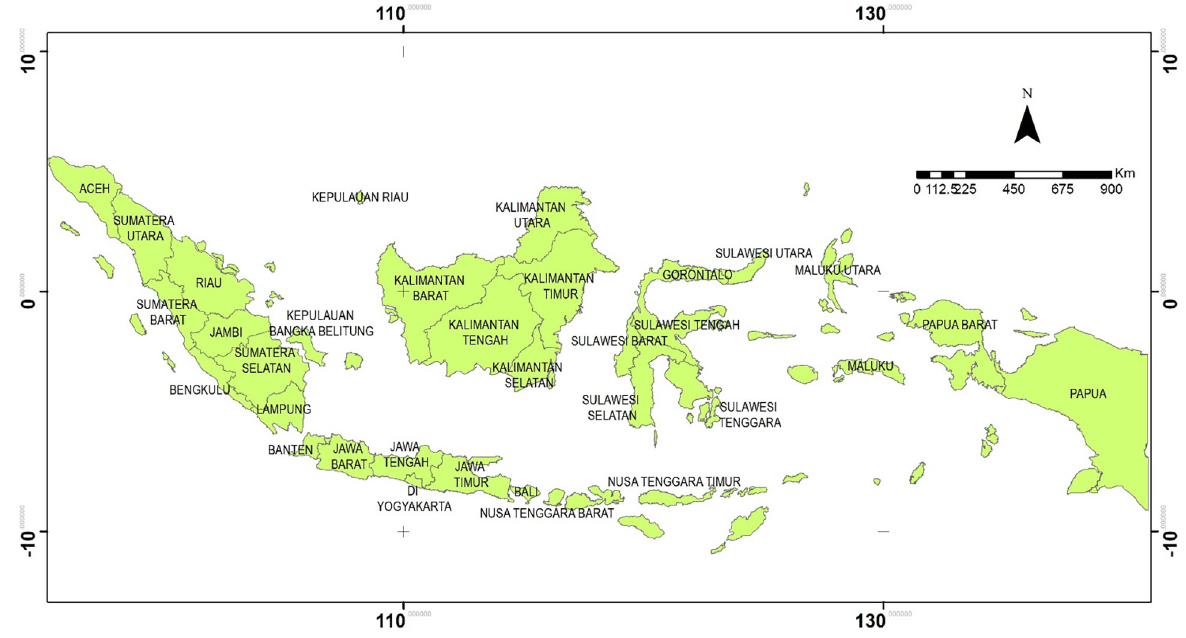
Fig. 1. Area of study. Source: own elaboration.